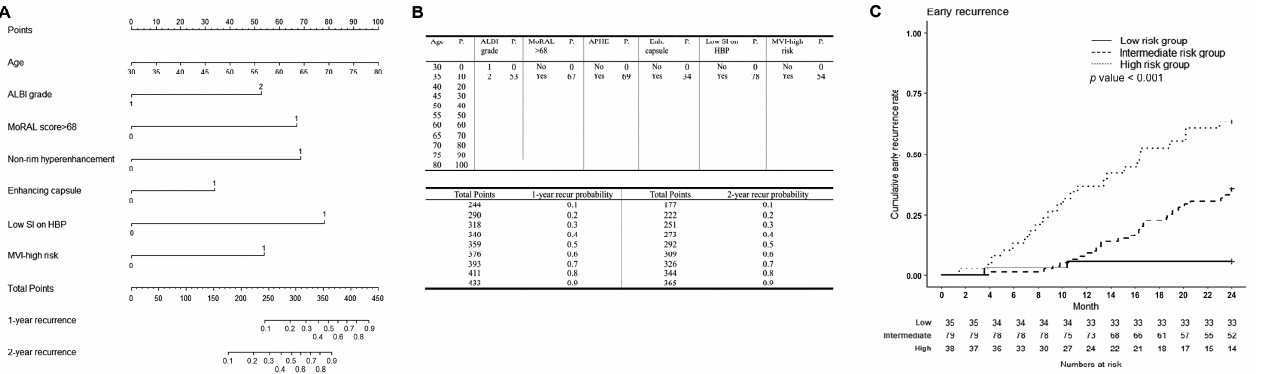
Figure 3. Nomogram to estimate early tumor recurrence after percutaneous radiofrequency ablation for HCC, and nomogram-based low-, intermediate- and high-risk groups for early tumor recurrence. ( A ) The included variables in the nomogram for early tumor recurrence are age, Albumin-Bilirubin grade 2 (reference: grade 1), MoRAL score > 68, non-rim hyperenhancement (reference: no enhancement), enhancing capsule (reference: no enhancing capsule), low signal intensity (SI) of the lesion on hepatobiliary phase on gadoxetic acid-enhanced liver MRI (reference: iso or high SI), and microvascular invasion-high risk group. ( B ) The prognostic points of each variable are shown in the upper table, and the estimated early tumor recurrence rate at 1 and 2 years after RFS for HCC according to the total points are shown in the lower table. ( C ) For early tumor recurrence, patients with nomogram scores in the lower quartile (<25%, 210.80 points) were classified as low-risk, those in the upper quartile (>25%, 289.66 points) as high-risk, and those in between (25–75%) were classified as intermediate-risk groups. The cumulative early tumor recurrence rates of the low-, intermediate-, and high-risk groups were 5.7% (95% CI 0.0–13.1%), 8.9% (95% CI 2.4–14.9%), and 39.5% (95% CI 21.8–53.2%) at 1